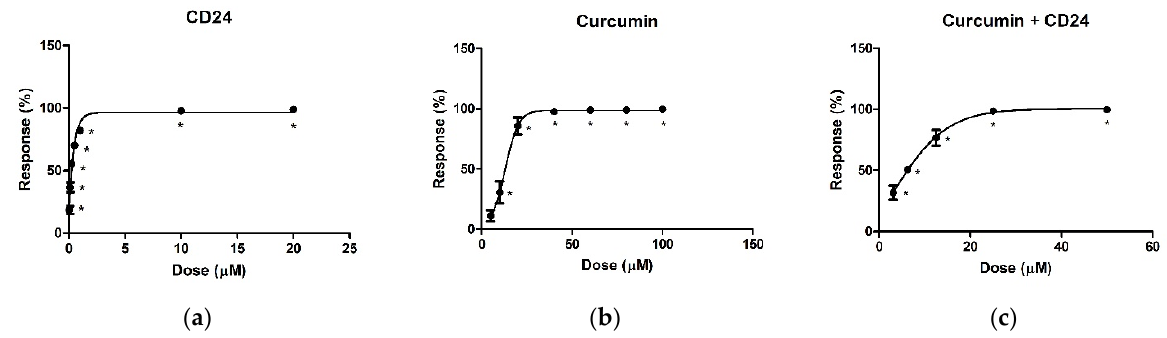
Figure 2. Dose–response curves for rhodesain inhibition by CD24 ( a ), curcumin ( b ), and CD24 + curcumin in combination ( c ). Each experiment was performed two times, each in duplicate with * p < 0.0001 vs. no inhibitor.